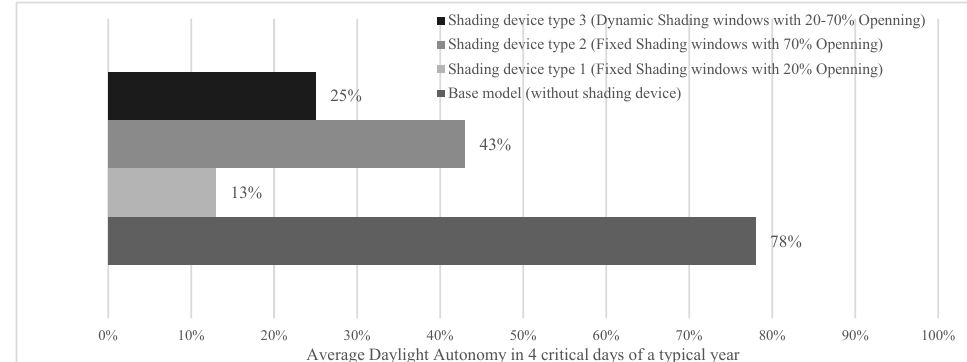
Figure 9. Average Daylight Autonomy in critical days of a typical year.